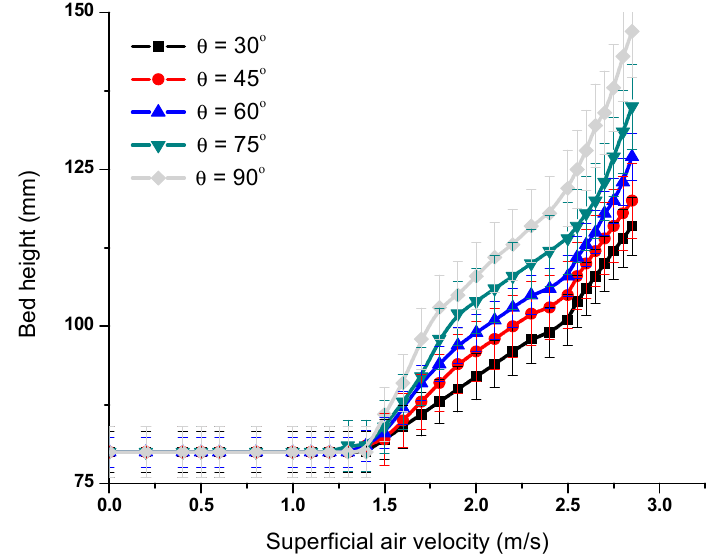
Figure 10. Bed height versus superficial velocity for different inclination angles.